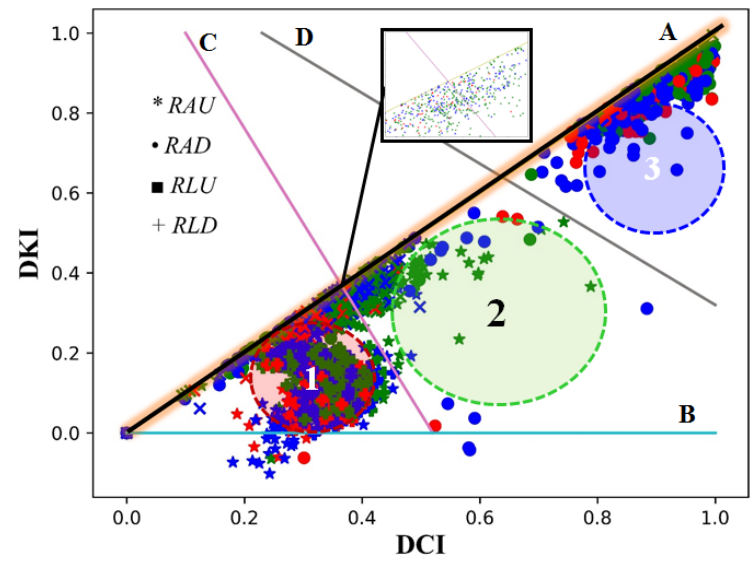
Figure 7. Main areas for vascular tone classifications: 1-Hypertonic, 2-Normotonic, 3-Hypotonic; red: inhalation, green: exhalation, and blue: interphase.